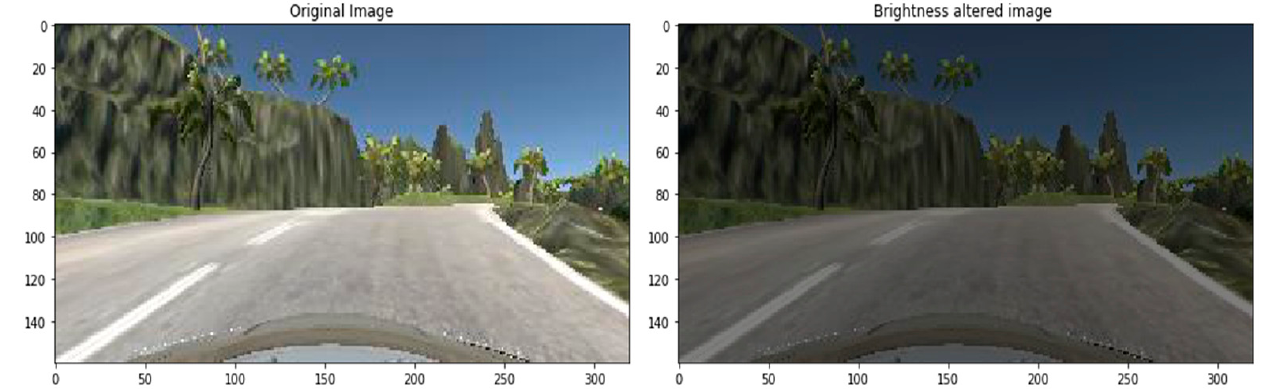
Figure 13. Brightness altered image.